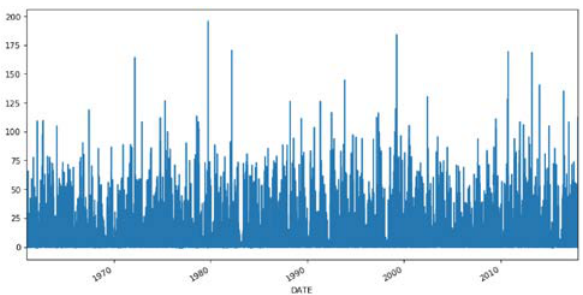
Figure 1. Line plot of Malaybalay rainfall between